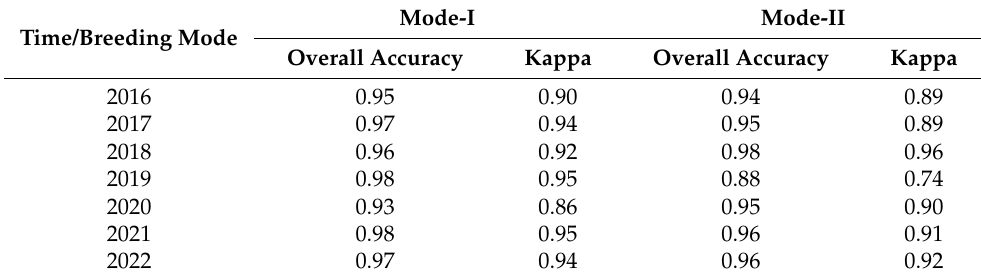
Table 3. Accuracy